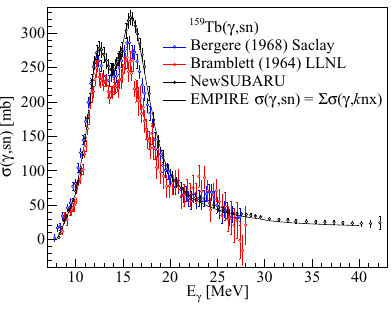
Figure 5. (Color online) The present total photoneutron cross sections, σ ( γ, sn ) for 159 Tb compared with the Livermore [22] and Saclay [23] data.